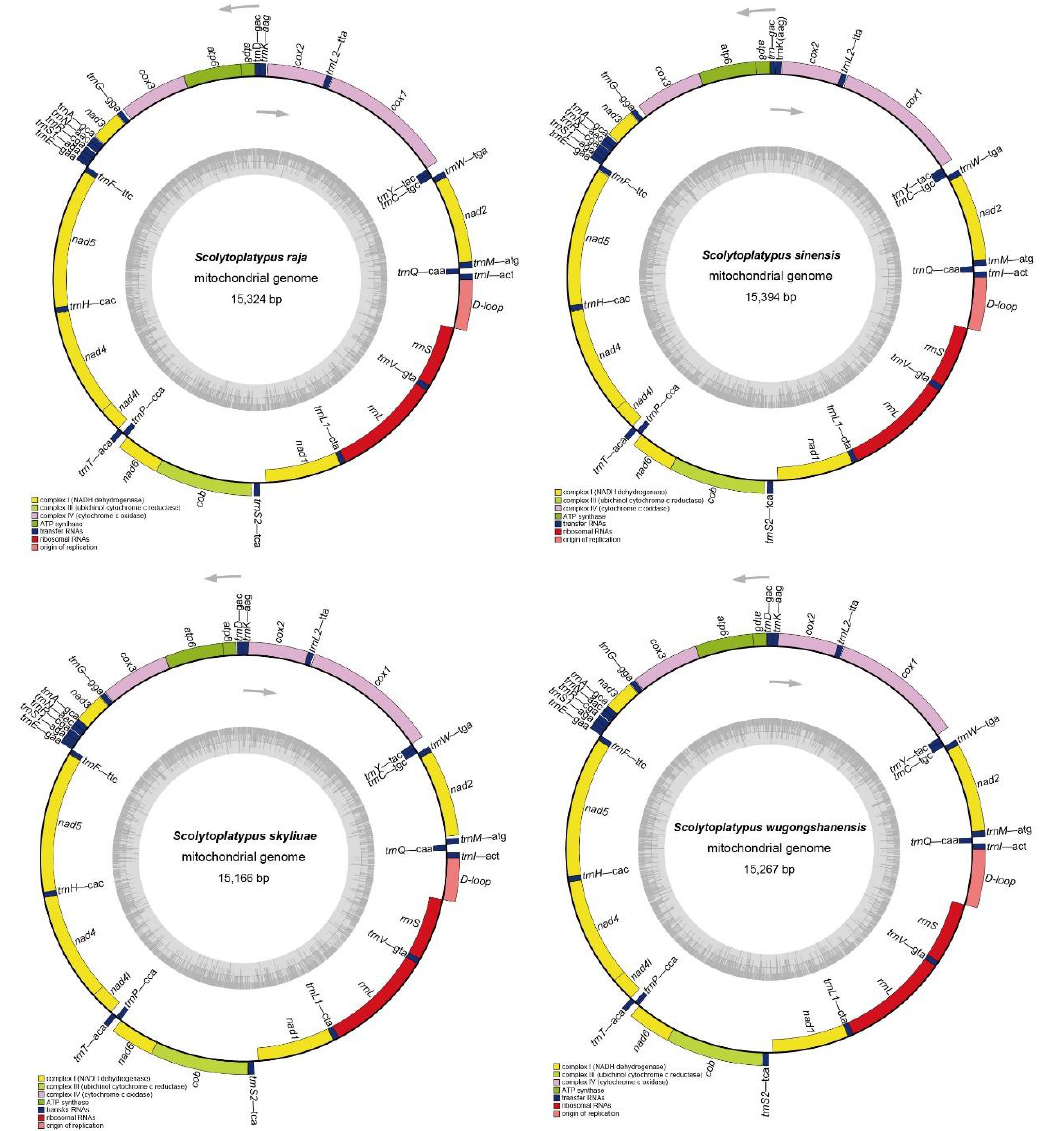
Figure 1. Circular map of the complete mitogenome of S. raja , S. sinensis , S. skyliuae, and S. wugongshanensis . Different colors indicate different types of genes and regions. Genes in the outer circle are located on the J-strand, and genes in the inner circle are located on the N-strand.